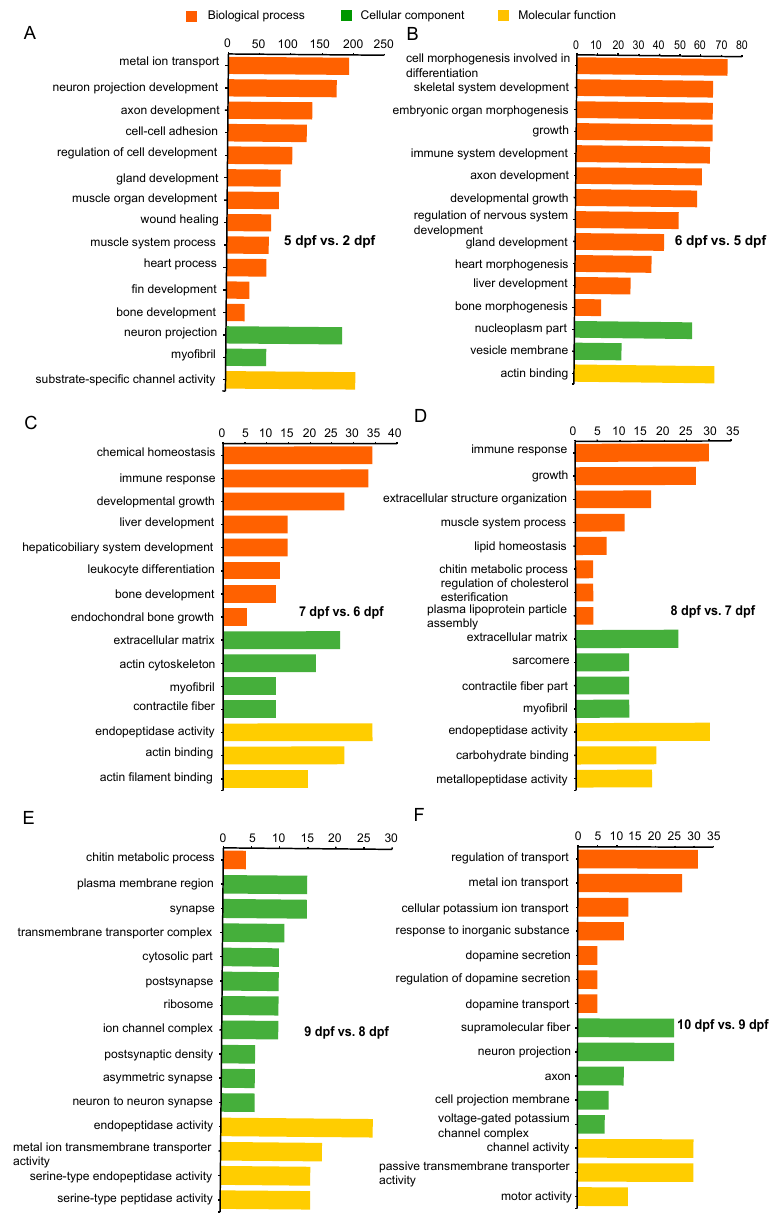
Figure 4. Gene Ontology (GO) functional enrichment analysis of differentially expressed genes (DEGs) at different development stages in channel catfish, Ictalurus punctatus . ( A ) 5 vs. 2 dpf, ( B ) 6 vs. 5 dpf, ( C ) 7 vs. 6 dpf, ( D ) 8 vs. 7 dpf, ( E ) 9 vs. 8 dpf and ( F ) 10 vs. 9 dpf. The horizontal axis indicates the number of DEGs between two sampling datasets, and the vertical axis represents the GO terms significantly enriched by the DEGs.